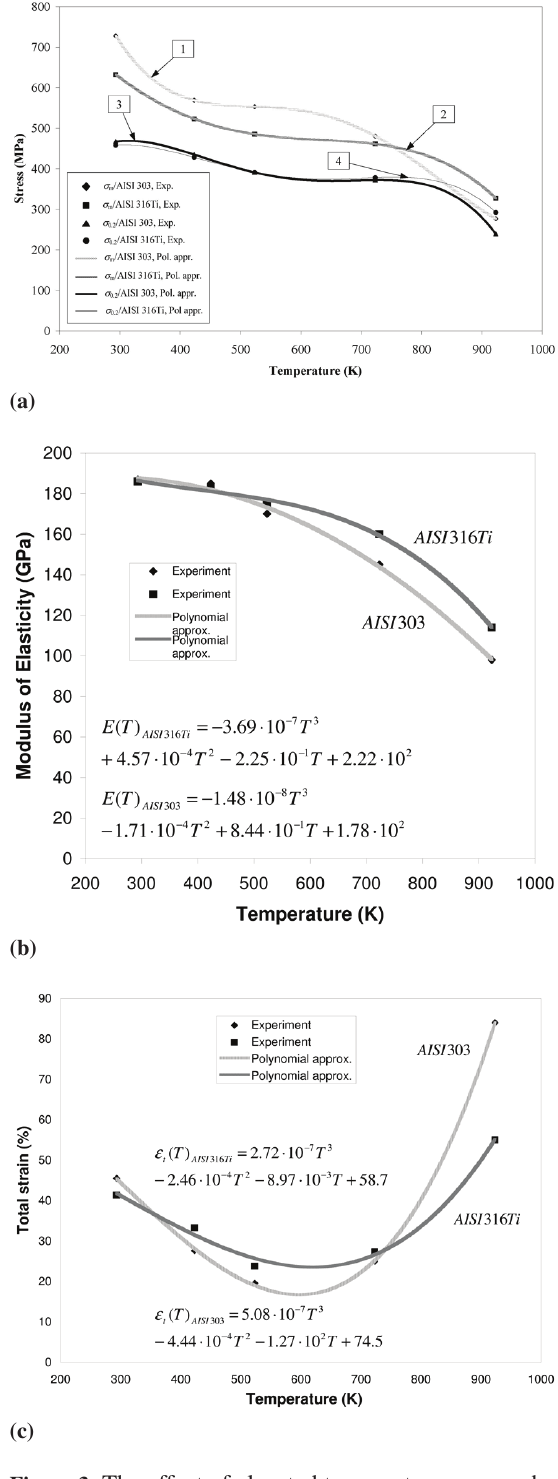
Figure 3. The effect of elevated temperatures on mechan- ical properties ( (cid:2) m , (cid:2) 0.2 ), modulus of elasticity ( E ) and total strain ( " t ) of AISI 303 steel and AISI 316Ti steel. (a) Mechanical properties ( (cid:2) m , (cid:2) 0.2 / versus temperatures. (b) Modulus of elasticity ( E ) versus temperatures. (c) Total strain ( " t / versus